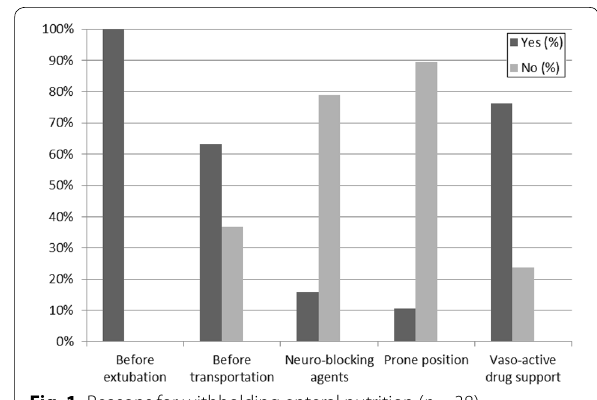
Fig. 1 Reasons for withholding enteral nutrition ( n